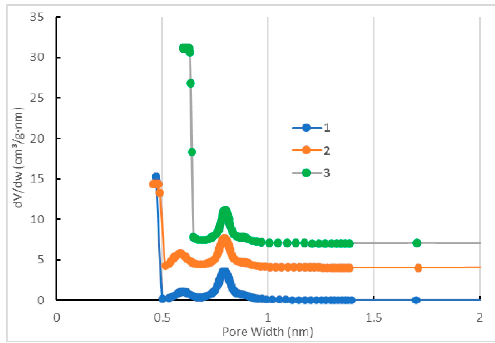
Figure 5. The distribution of the micropore volume on the sizes calculated by the Horvath–Kawazoe method for the HKUST-1 mw (1), HKUST-1 mw pressurized (2), and HKUST-1 solv.1 (3) samples.